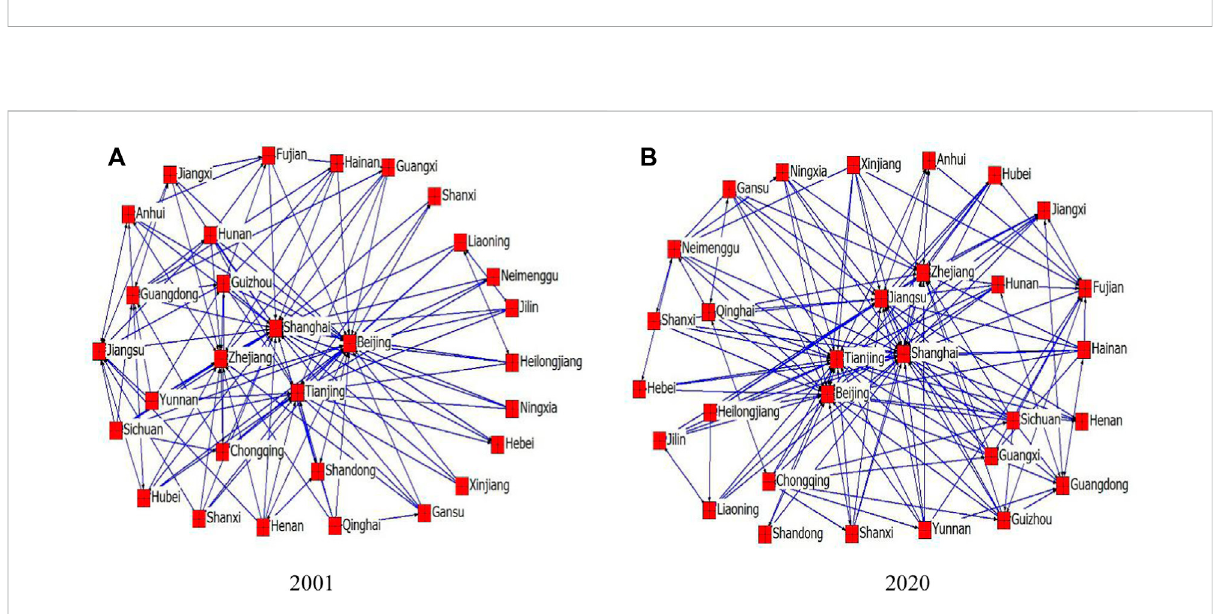
FIGURE 3 Structure of ALTFP in China in 2001 (A) and 2020 (B)